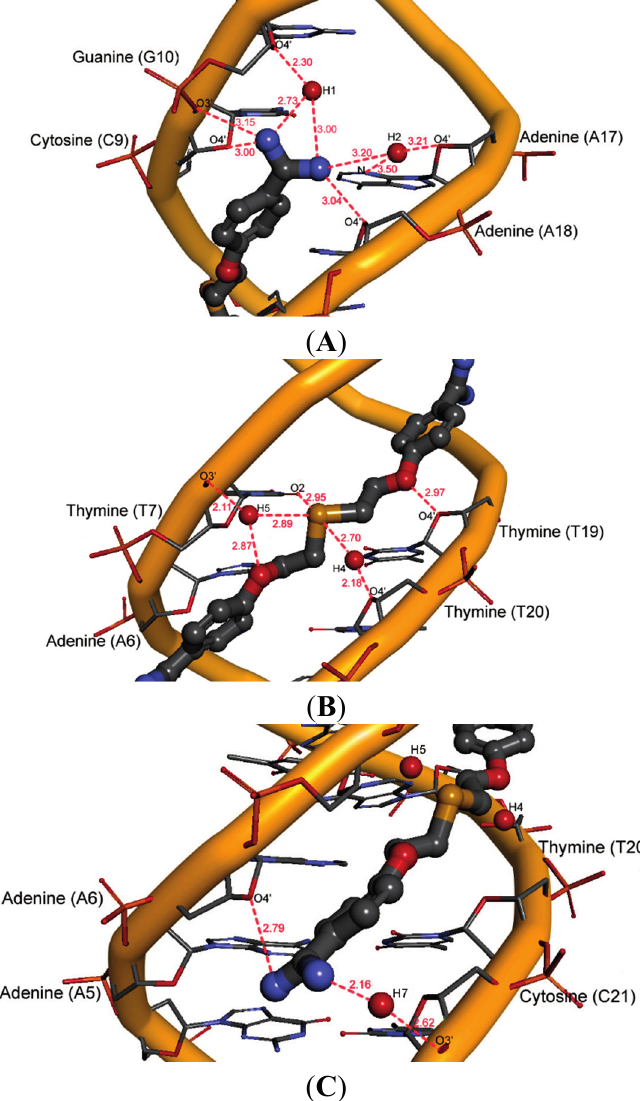
Figure 8. A view of five hydration sites for compound 10 in the minor groove (red lines—hydrogen bonds; length [Å]). ( A ) hydration sites H1–H2; ( B ) hydration sites H4–H5; ( C ) hydration site